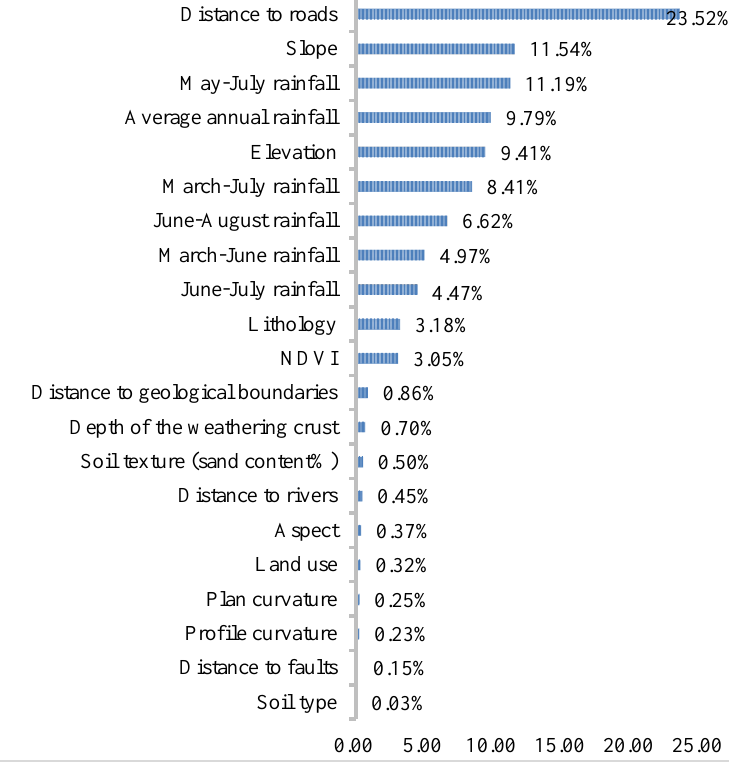
Figure 5. Importance of hazard-causative factors.